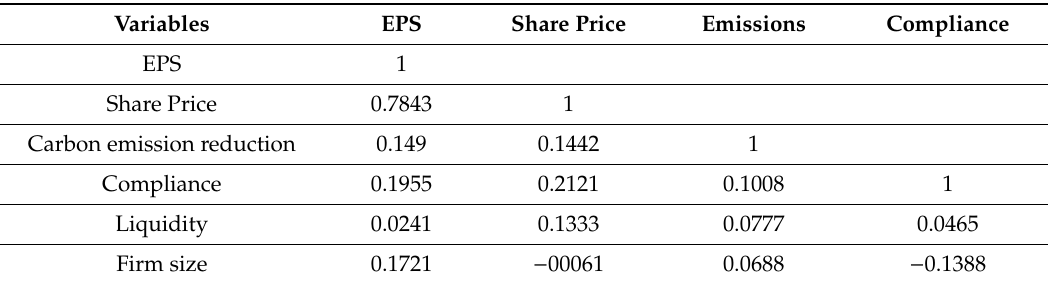
Table 4. Correlation